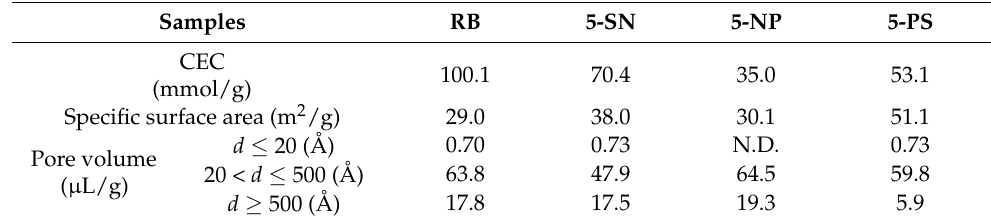
Table 1. Characteristics of